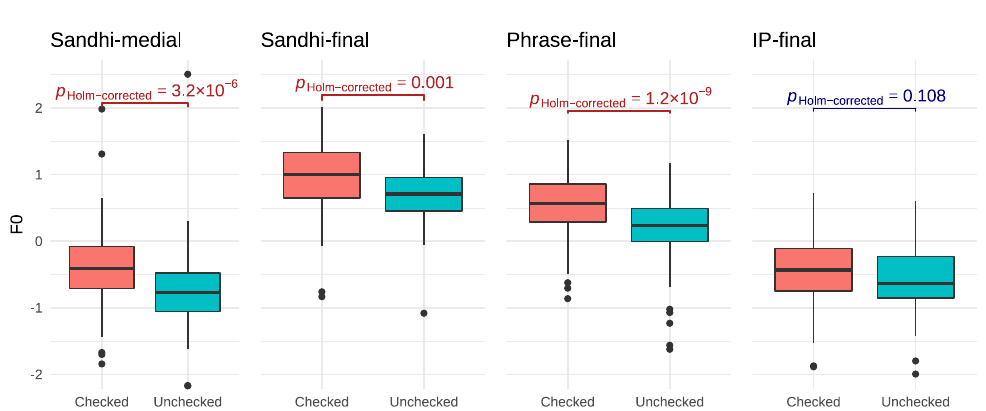
Figure 8. The variation of f0 influenced by phonemic type and prosodic position. Significant p ‑values ( p ⩽ 0.05 ) are marked in red, which indicates that the f0 difference between checked and unchecked syllables is significant in that prosodic